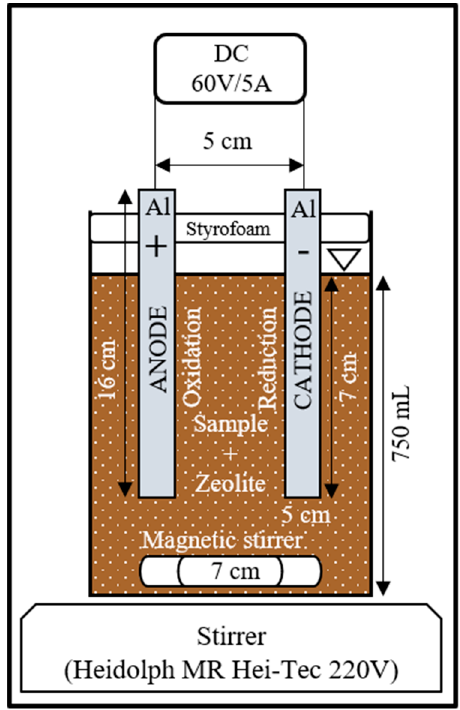
Figure 2. Experimental set-up for the zeolite augmented electrocoagulation treatment process.